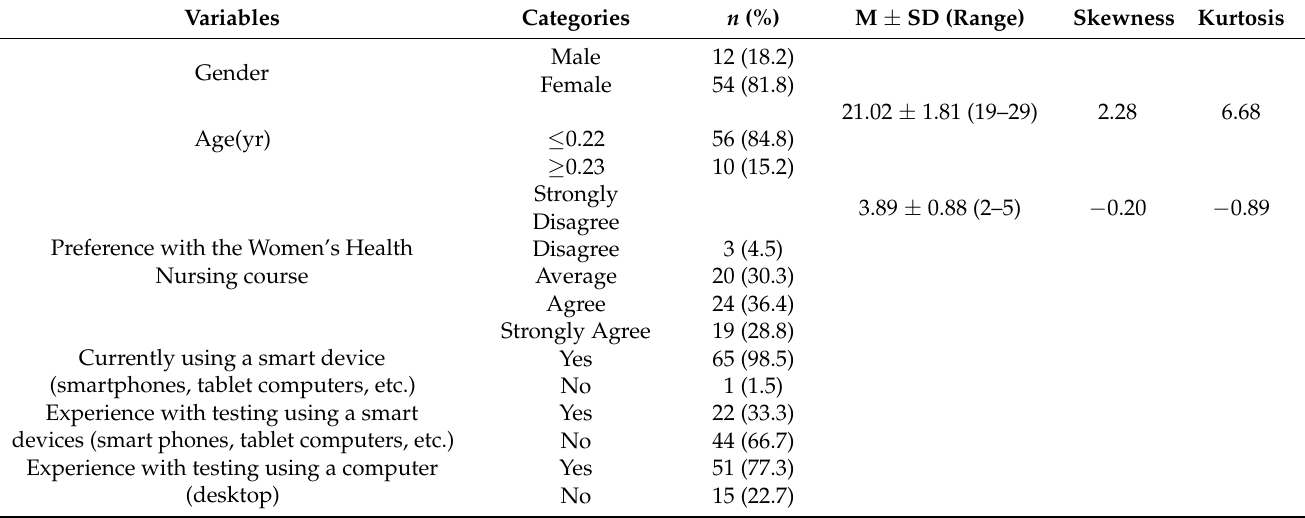
Table 1. General characteristics of nursing students ( n =